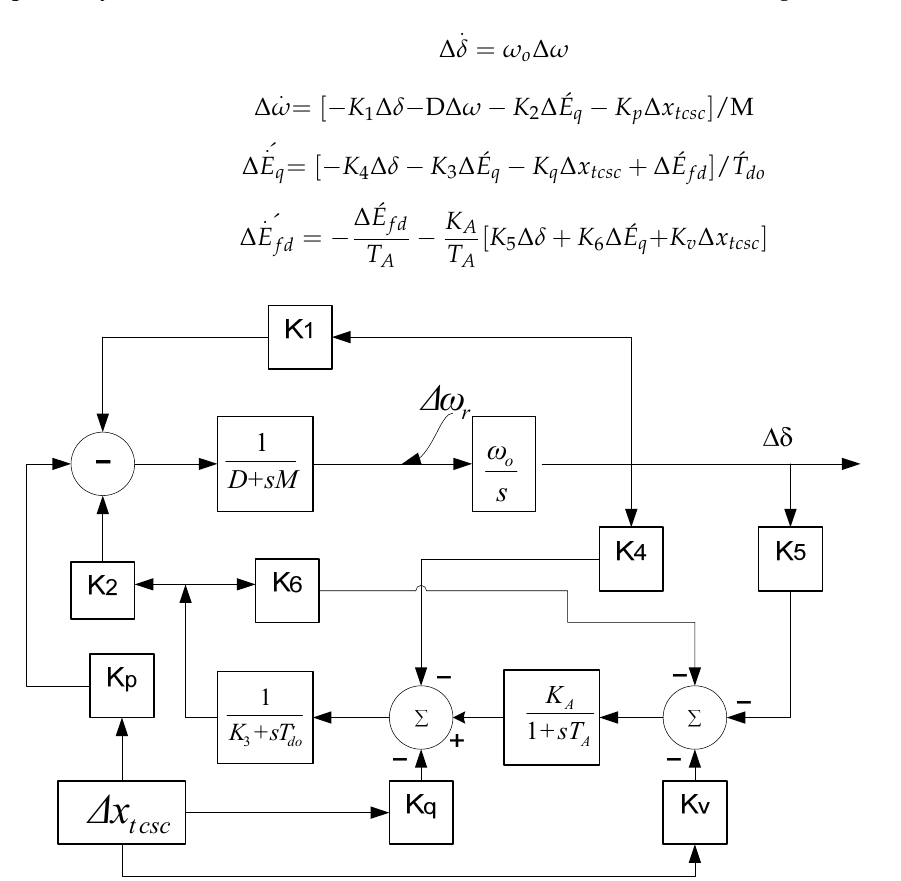
Figure 2. Extended Phillips–Heffron model of the single-machine infinite-bus power system installed with a TCSC stabiliser.